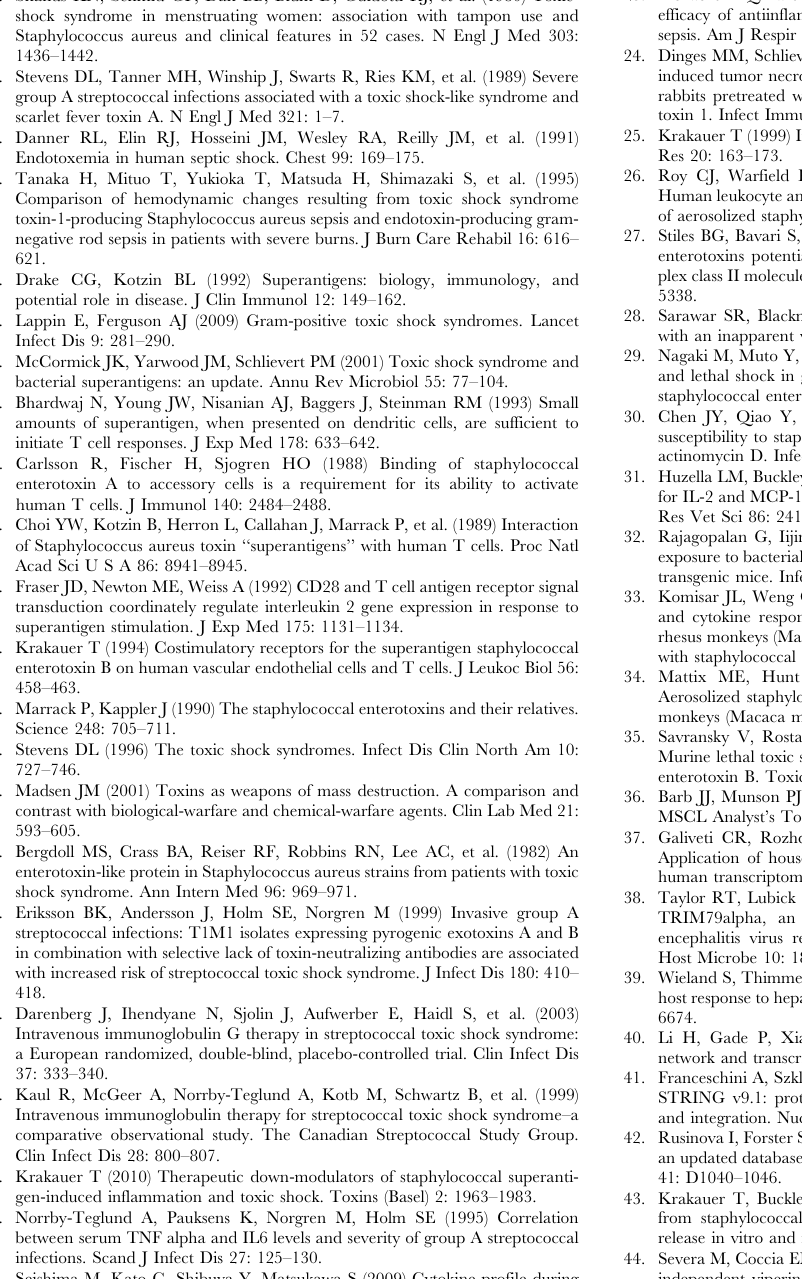
Table S1 All probesets in any tissue meeting selection criteria ( # 5% FDR; $ 1.5-fold-change compared